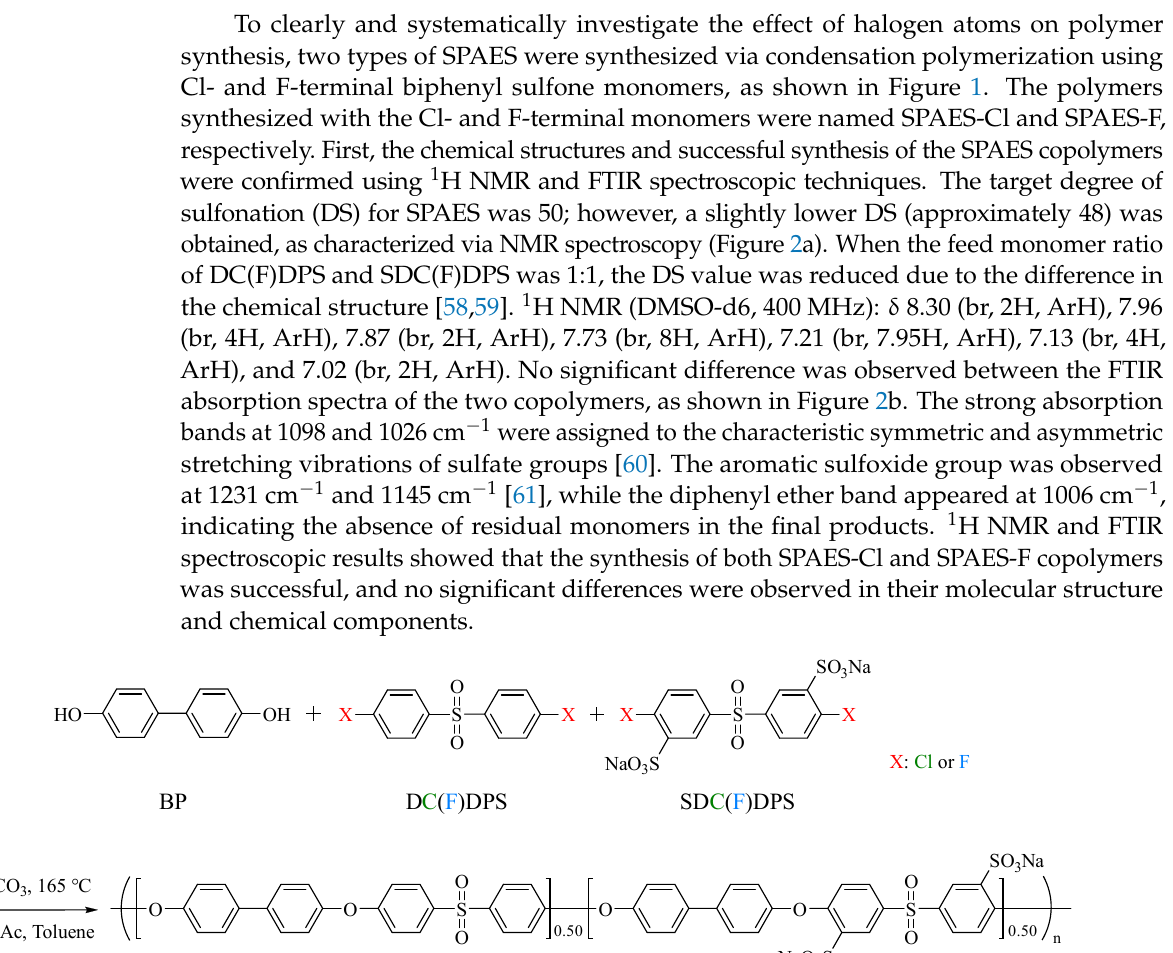
Figure 2. ( a ) 1 H NMR and ( b ) FTIR spectra, ( c ) XRD patterns, and ( d ) TGA curves of SPAES copolymers. The crystallinity and structural properties of the SPAES copolymers were character ‐ ized via XRD patterns, as shown in Figure 2c , where the intensity of X ‐ ray scattering is plotted against the diffraction angle, 2 θ . Both the SPAES ‐ Cl and SPAES ‐ F copolymers did not show any sharp, narrow peaks, indicating a lack of crystallinity and a completely amorphous nature of the copolymer. The amorphous nature of SPAES copolymers is due to the random arrangement of the monomeric units, leading to the perturbation of the long ‐ range order between the chains [46,62]. The d ‐ spacing was calculated using Bragg’s relation: n λ = 2dsin( θ ), where n is an integer (1), λ is the wavelength of the incident light (1.54 Å), and d is the average inter/intrachain distance of the copolymer. The maximum intensity peak was observed at 18.8  , and therefore, the d ‐ spacing was determined to be approximately 4.7 Å for both copolymers. Figure 2d shows the TGA curves of the copolymers in the Na + form. Less than 5% weight loss occurred initially up to ~420 °C due to the removal of bound water. Thereafter, as the polymer main chain decomposed, a significant amount of weight loss occurred.